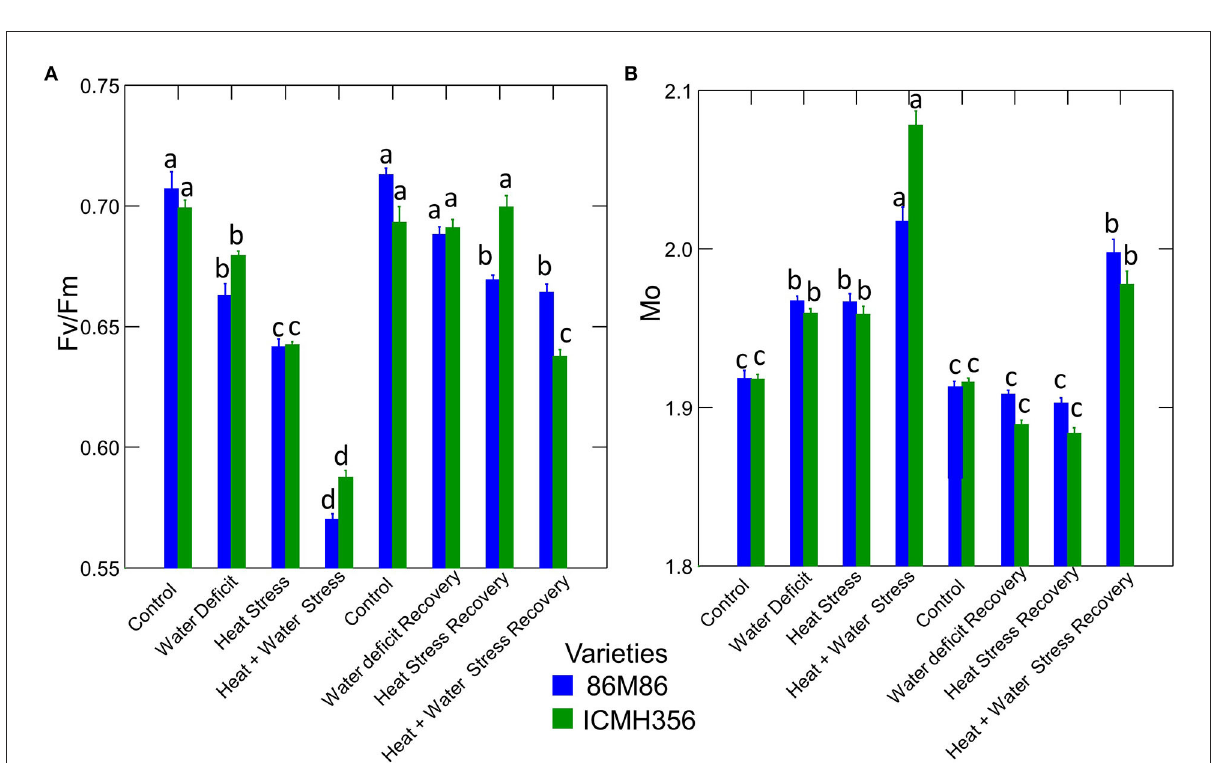
FIGURE6 Maximum quantum yield of PSII (Fv/Fm) (A) and the Net rate of PS II RC closure (Mo) in two varieties of pearl millet under water-deficit stress and heat stress in isolation and in combination and at recovery from stress (B) . Bars represent SE. Letters indicate significance at 0.05, and different letters indicate significant difference between